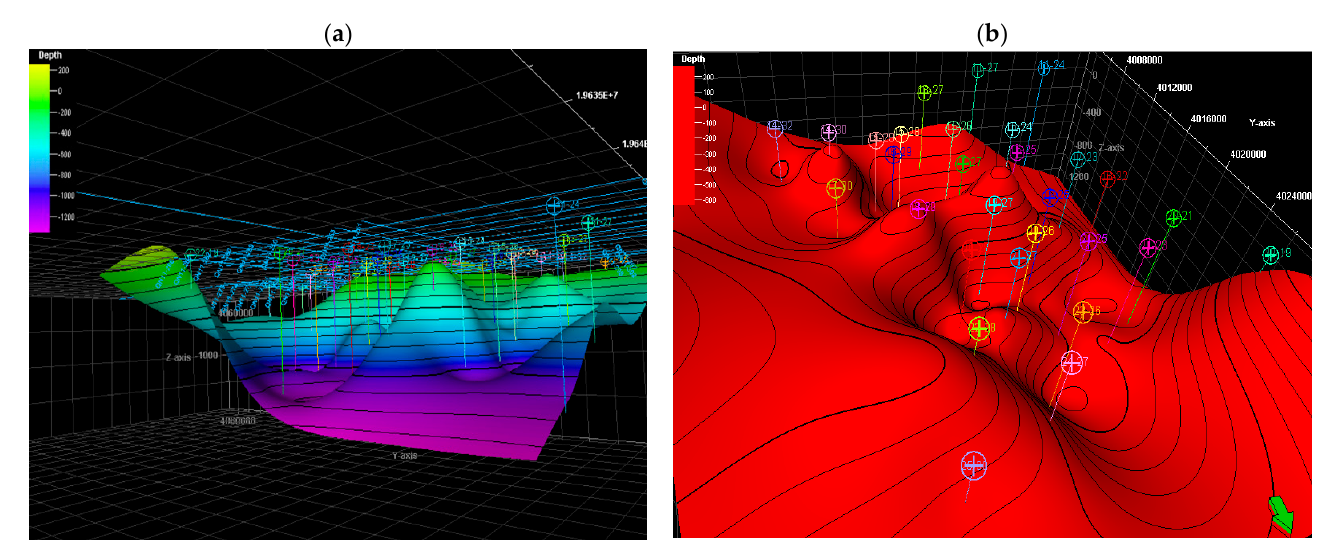
Figure 11. ( a , b ) The coal formation in the subject CBM gas field from two different views. The thickness of the coal layer is in the range of 2–8.3 m.